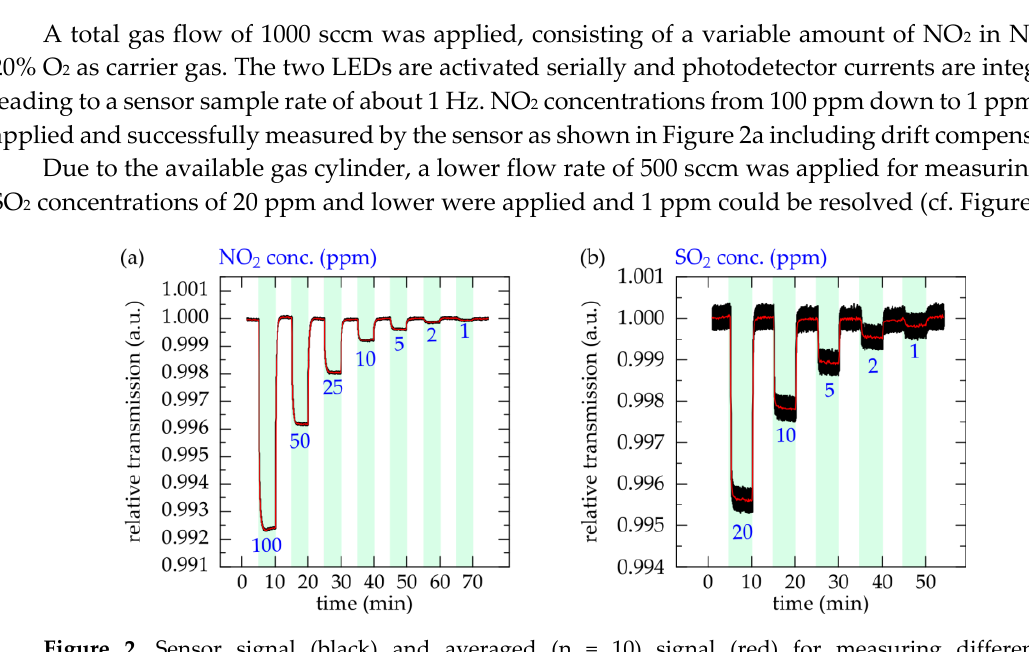
Figure 2. Sensor signal (black) and averaged (n = 10) signal (red) for measuring different concentrations of ( a ) NO 2 (395-nm-LED) and ( b ) SO 2